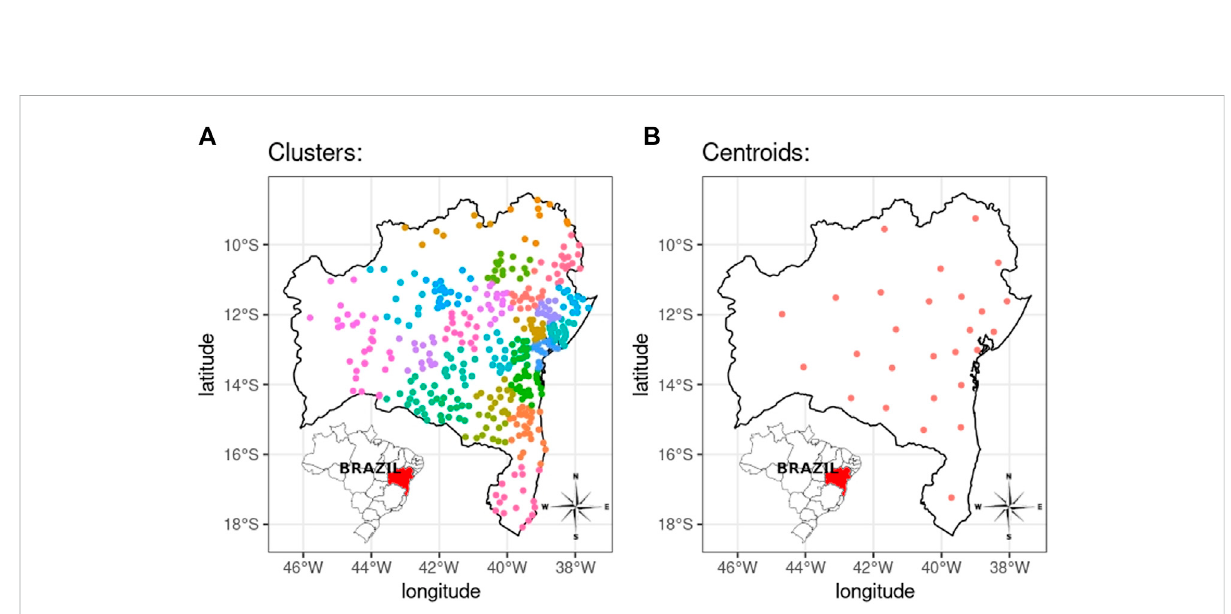
FIGURE 3 Grouping of municipalities in the 27 clusters identi fi ed in the map of the State of